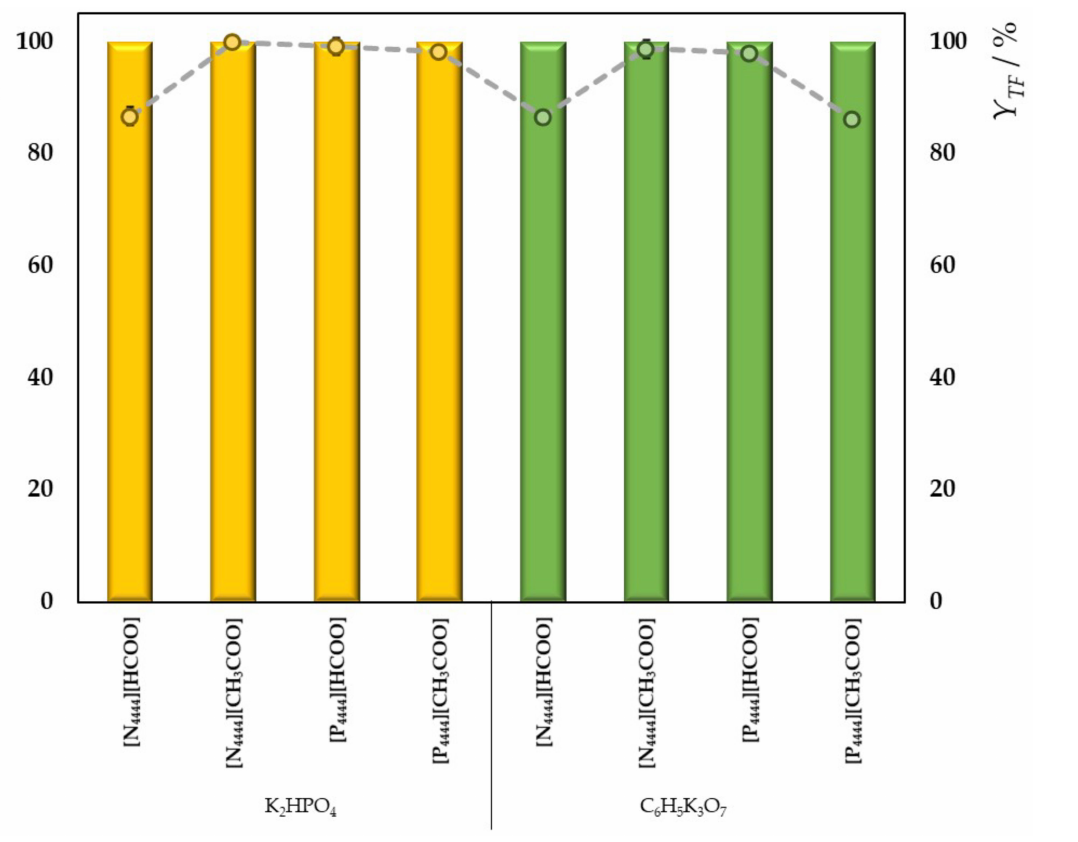
Figure 4. Extraction efficiencies ( EE TF %, primary scale, bars) and recovery yield ( Y TF %, secondary scale, points) of transferrin achieved with ABSs comprising organic acid-derived ILs and K 2 HPO 4 (yellow, left) or C 6 H 5 K 3 O 7 (green, right) at 25 ◦ C and atmospheric